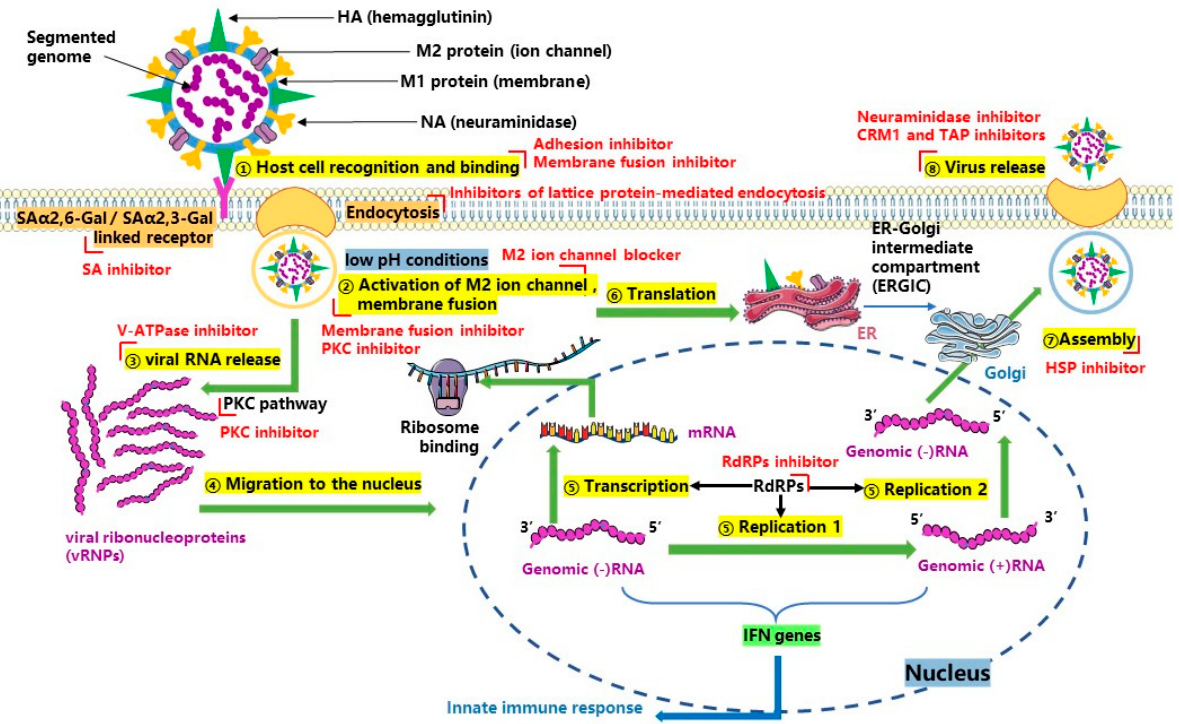
Figure 1. Replication cycle of the influenza virus in host cells, and targets for antiviral drugs and compounds which are marked with the red “ ∟ ” symbols.